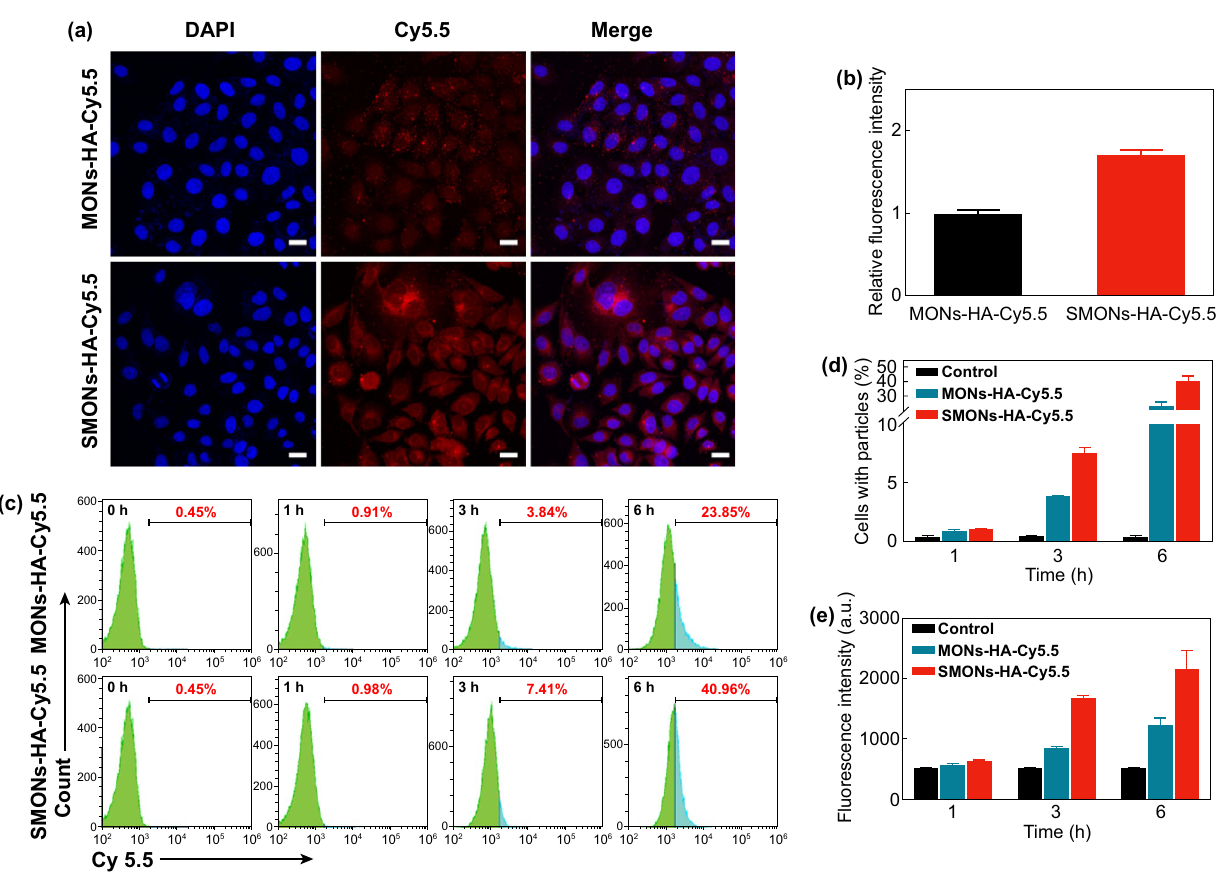
Fig. 3 Cellular uptake. a CLSM images and b relative fluorescence intensity analysis of MCF-7 cells incubated with the MONs-HA-Cy5.5 and SMONs-HA-Cy5.5 for 6 h. Scale bars, 25 µm. c Flow cytometry, d relative cellular uptake efficiency and e mean fluorescence intensity of MCF-7 cells incubated with the MONs-HA-Cy5.5 and SMONs-HA-Cy5.5 for 1, 3, 6